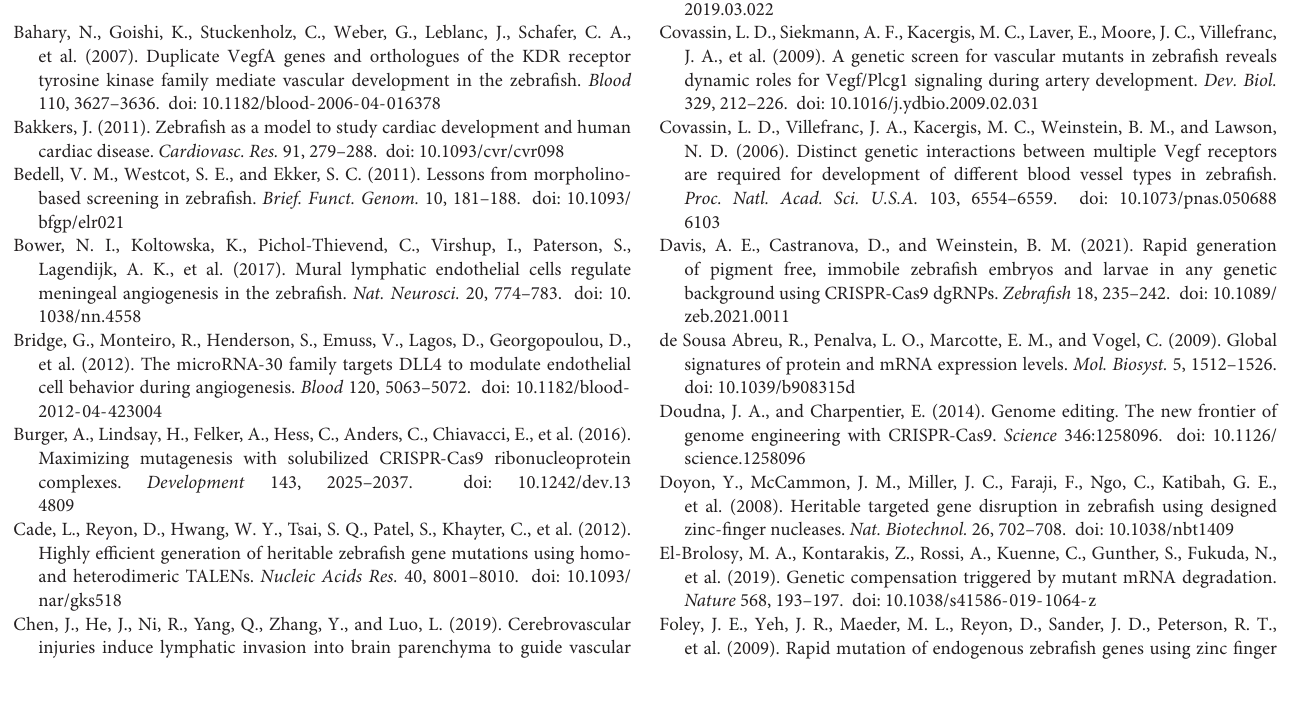
EGF domain (Ca-EGF), and two collagen repeat domains (ColA and ColB).